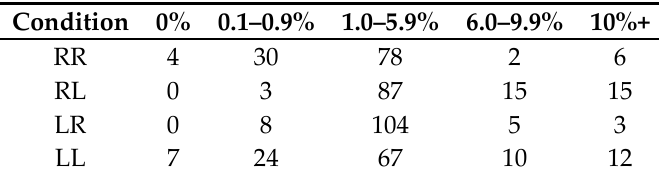
Table 2. Throws by Range of Absolute Percent Error.